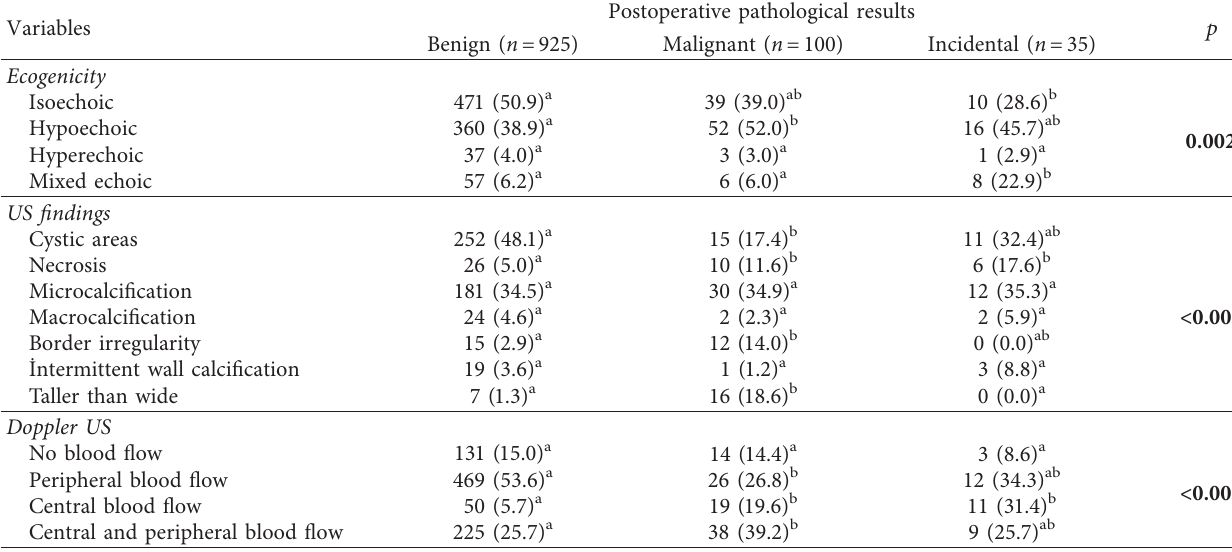
Table 5: Comparison of postoperative pathological results with US findings.